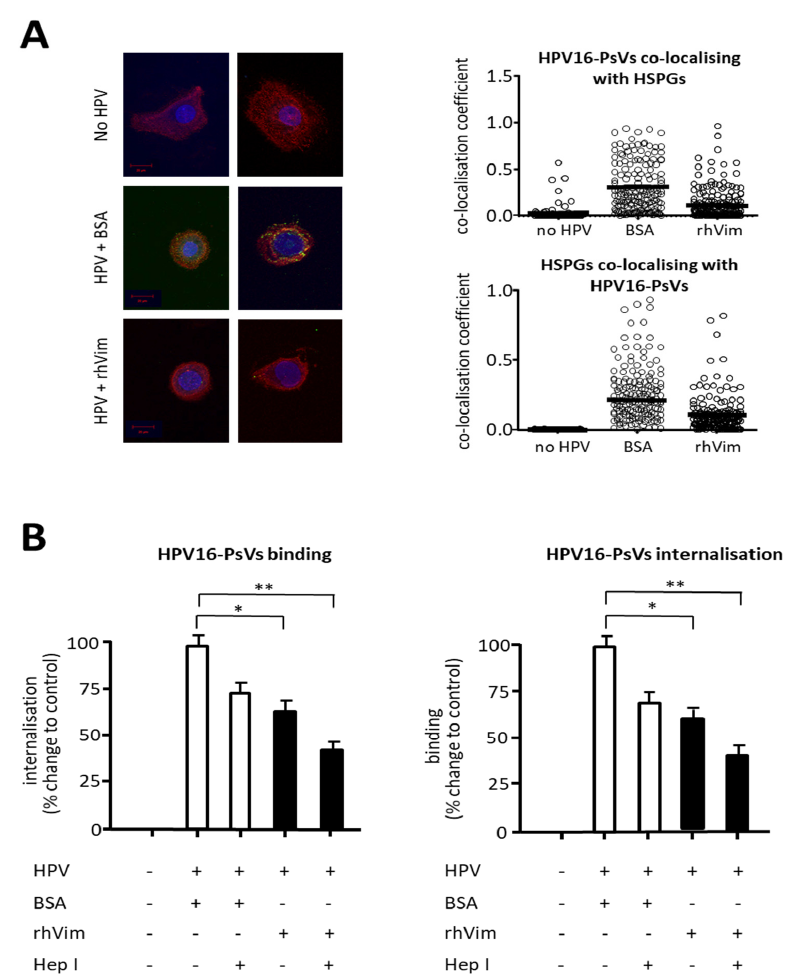
HSPGs (Figure 4A, top panel) and HSPGs co-localising with HPV (Figure 4A, bottom panel) revealed a high degree of co-localisation between the HSPGs and HPV16-PsVs pre-incubated with BSA control. In contrast, rhVim pre-incubated viral particles showed a significantly lower co-localisation coefficient with surface-expressed HSPGs compared to control particles (Figure 4A, top panel). Similarly, HSPGs showed less co-localisation with the rhVim pre-incubated virions (Figure 4A, bottom panel), strengthening the observation that rhVim decreases binding of HPV16-PsVs to surface HSPGs of NIKS cells.